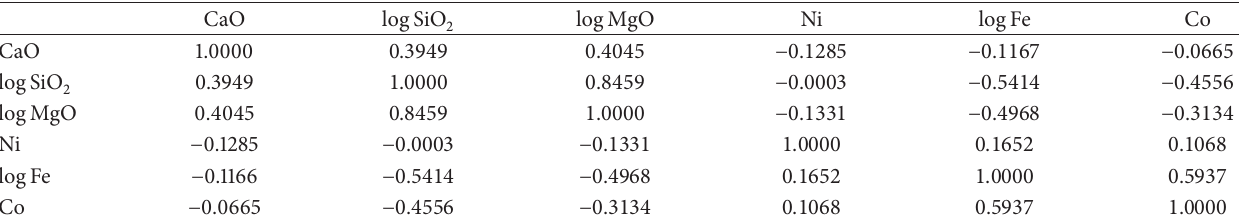
Table 2: Pearson’s correlation matrix of the percentages of CaO, log SiO 2 , log MgO, Ni, log Fe, and Co observed over a regular lattice of size 7 × 14 . Source of data: Tahir